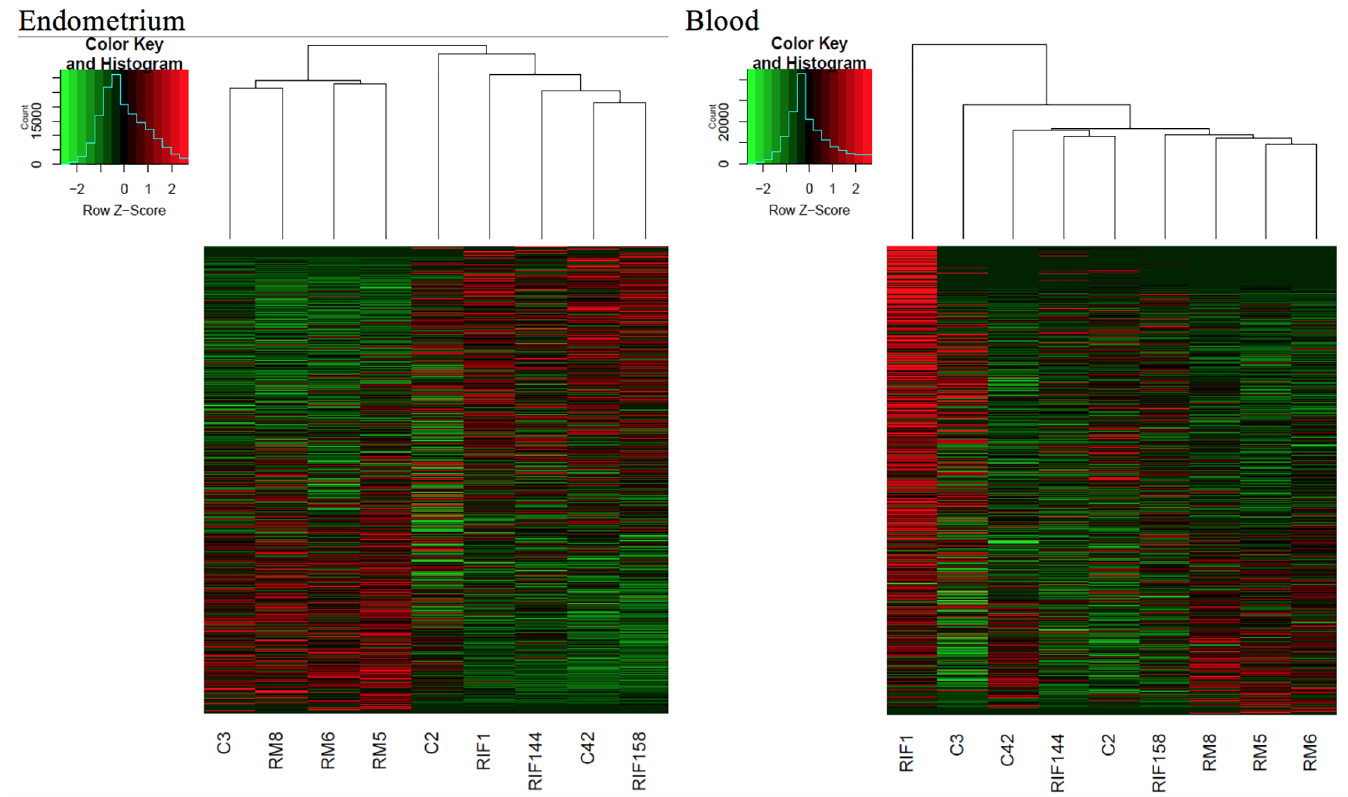
Fig 1. Unsupervised clustering of all gene expression in 9 paired samples, 3 with recurrentimplantation failure (RIF), 3 with recurrentmiscarriage (RM), and 3 fertile controls (C).